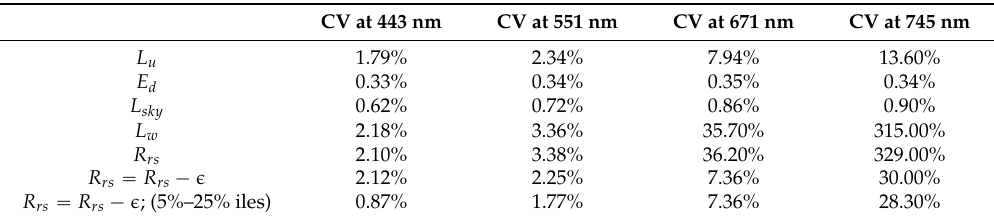
Figure 3. Example of DALEC processing sequence at Scott Reef on 12 April 2015 for 193 spectra spanning approximately 1 km. ( a ) L u ; ( b ) E d and L sky on two axes ( L sky in red on the right axis); ( c ) L w ; ( d ) instantaneous R rs ; ( e ) instantaneous R rs after similarity spectrum correction with 5th and 25th percentile spectra indicated in red; ( f ) average and standard deviation of the aggregated R rs ( i.e. , of the 5–25 percentile range of the spectra). Table 2. Coefficients of variation (CV = standard deviation/average) for all radiometric quantities for the DALEC spectra shown in Figure 3.